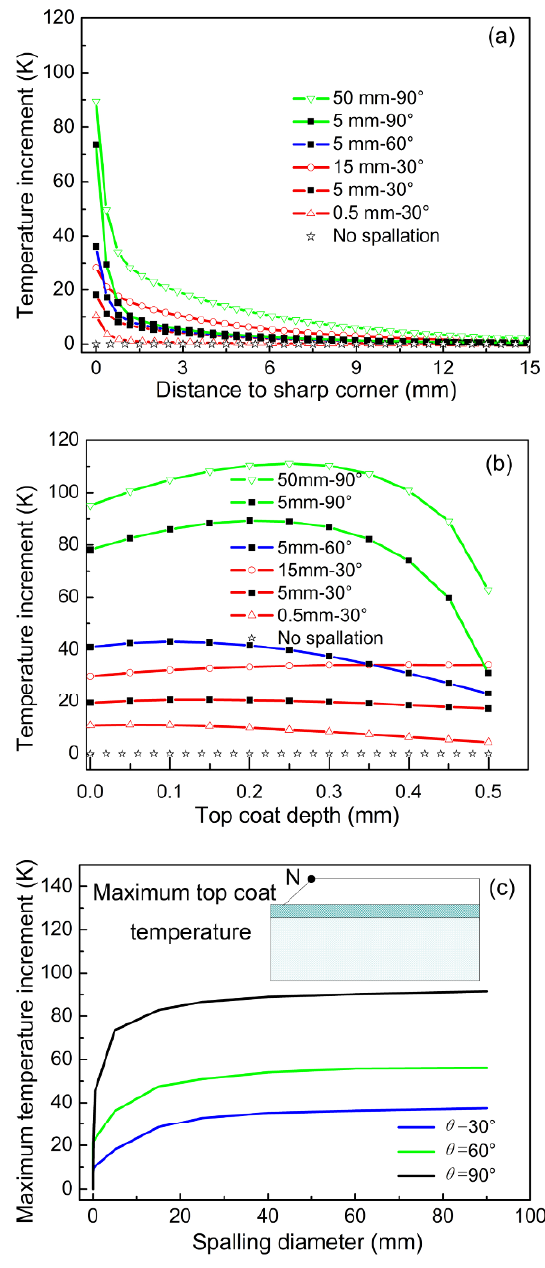
Fig. 7 Temperature increments along the top-coat surface (a) and its in-depth directions (b) with different spallation dimensions. (c) is the maximum temperature increment in top-coat surface (corresponding to the sharp corner of top-coat, point N) as a function of the tilt angle and the spallation